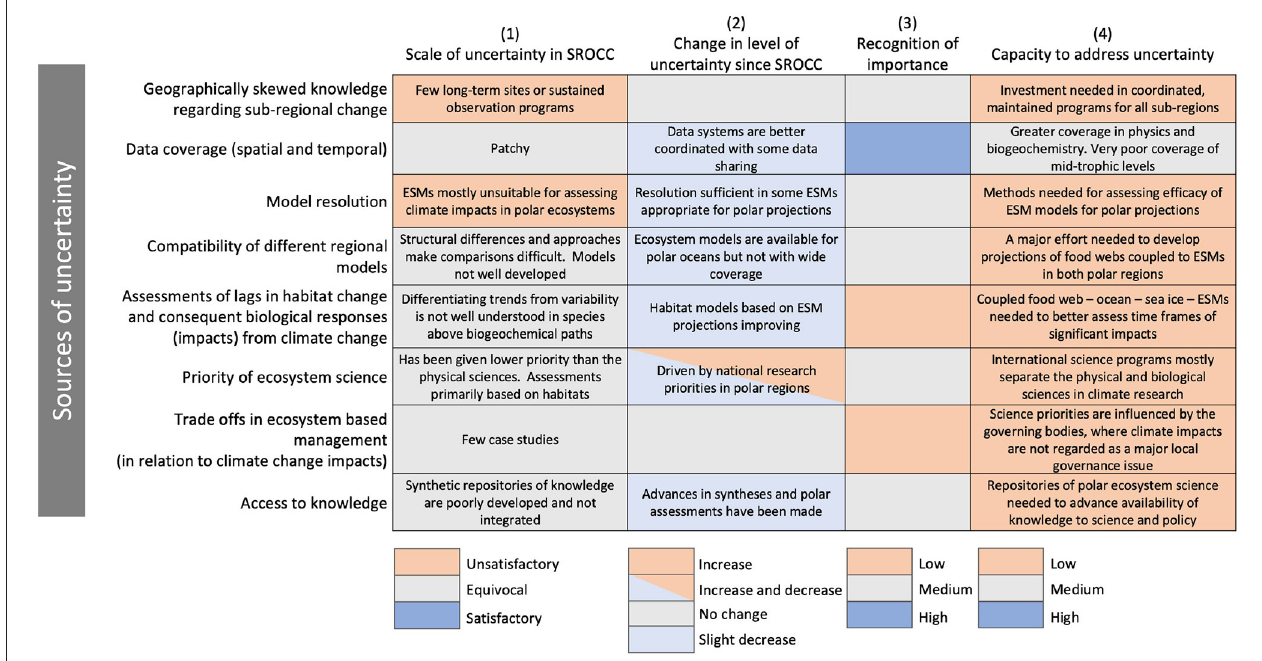
FIGURE 1 | Summary of capacity to advise on, and prognoses for, the impacts of climate change on ecosystems of the polar regions. For different sources of uncertainty, qualitative judgement is provided on (1) the scale of uncertainty in SROCC (blue, satisfactory; gray, equivocal; red, unsatisfactory); (2) change in the level of uncertainty since SROCC (blue, decrease; gray, no change; red, increase); (3) level of recognition of the importance of each source of uncertainty by research and policy communities, i.e., recognition that each source needs to be addressed (blue, high; gray, medium; red, low); and (4) existing capacity to address each source of uncertainty in assessment and decision making (blue, high; gray, medium; red, low). Cells indicate important scientific issues causing